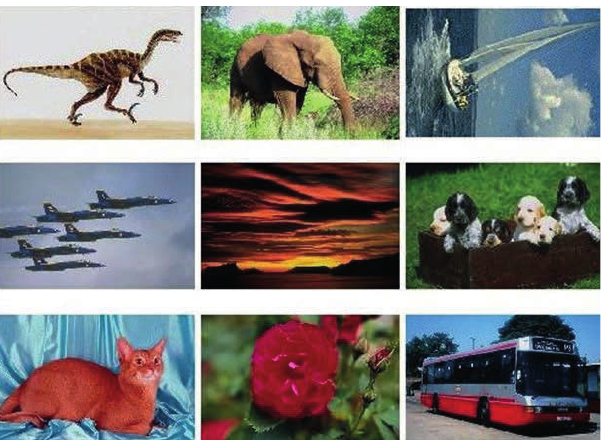
Fig. 7. Query images used in image